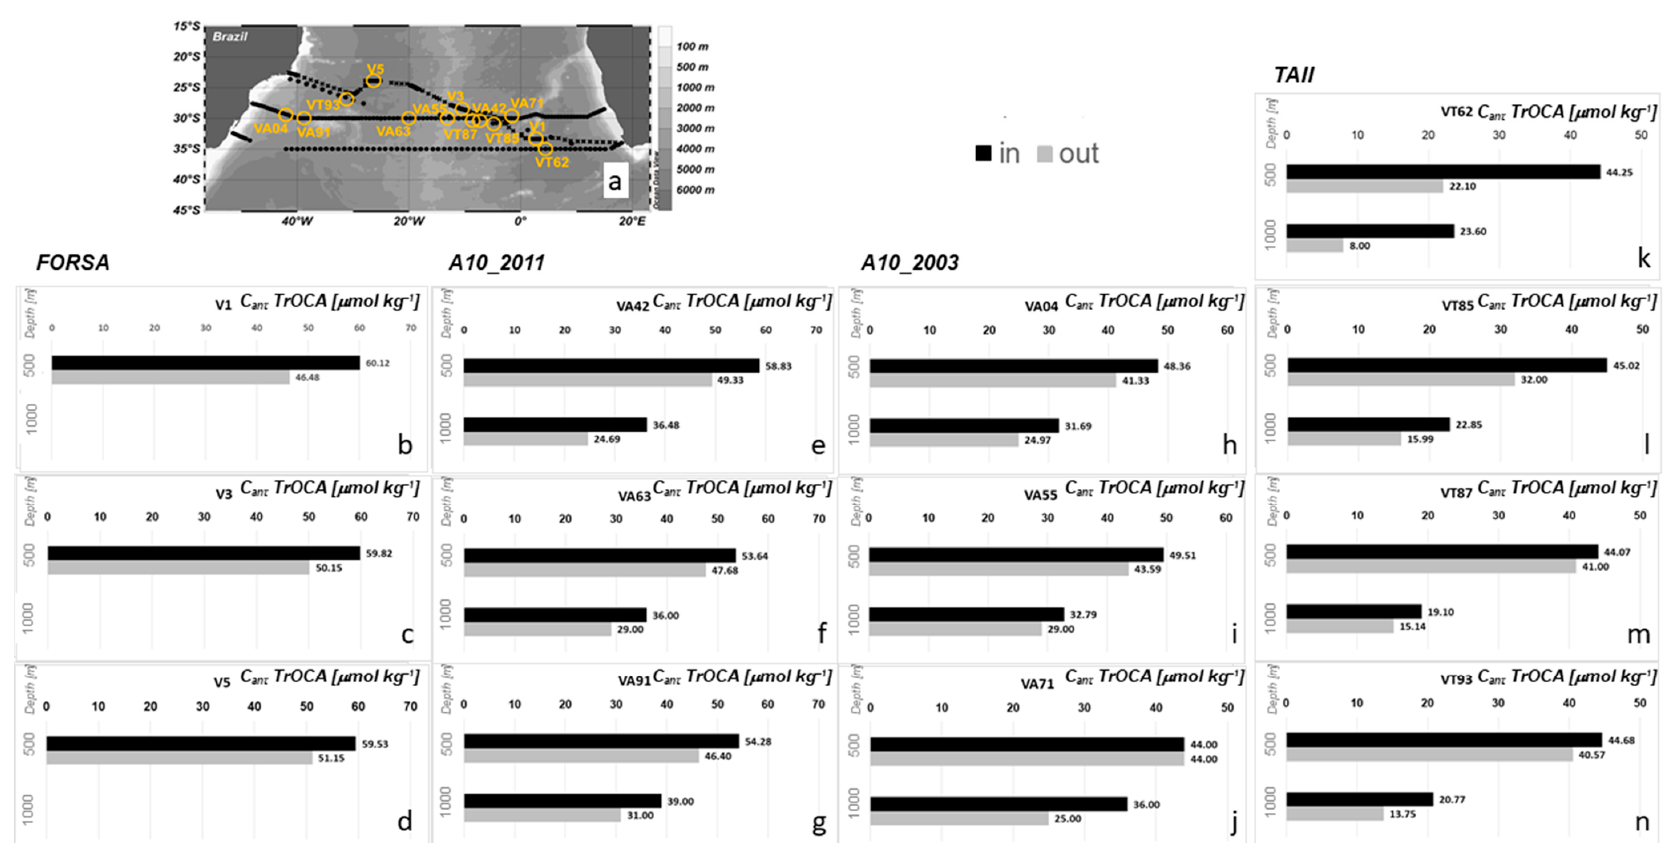
Figure 9. ( a ) Map of the cruise sections and sampled eddies. For a complete description of this map, please see Figure 1; ( b – n ) inside-outside eddy anthropogenic carbon (C ant-TrOCA µ mol kg − 1 ) content at 500 m and 1000 m depth; ( b – d ) V1, V3, and V5, sampled in the FORSA cruise (the white part at 1000 m correspond to non-sampled depths outside of these eddies); ( e – g ) VA42, VA63, and VA91, sampled in the A10_2011 cruise; ( h – j ) VA04, VA55, and VA71, sampled in the A10_2003 cruise; ( k – n ) VT62 (TAII_01 section), VT85 (TAII_02 section), VT87 (TAII_02 section), and VT93 (TAII_02 section), sampled in the TAII cruise.